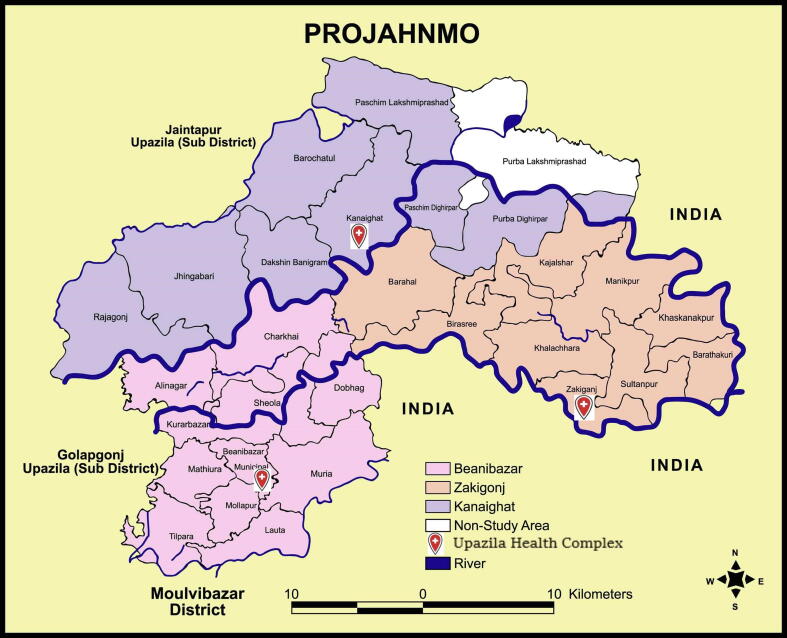
PROJAHNMO study area.